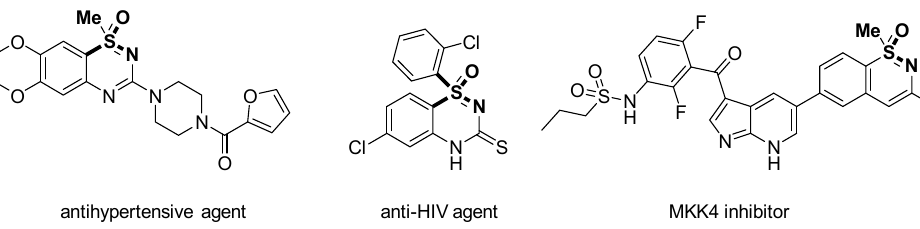
Figure 1. Representatives of biologically active compounds containing sulfoximines moiety.